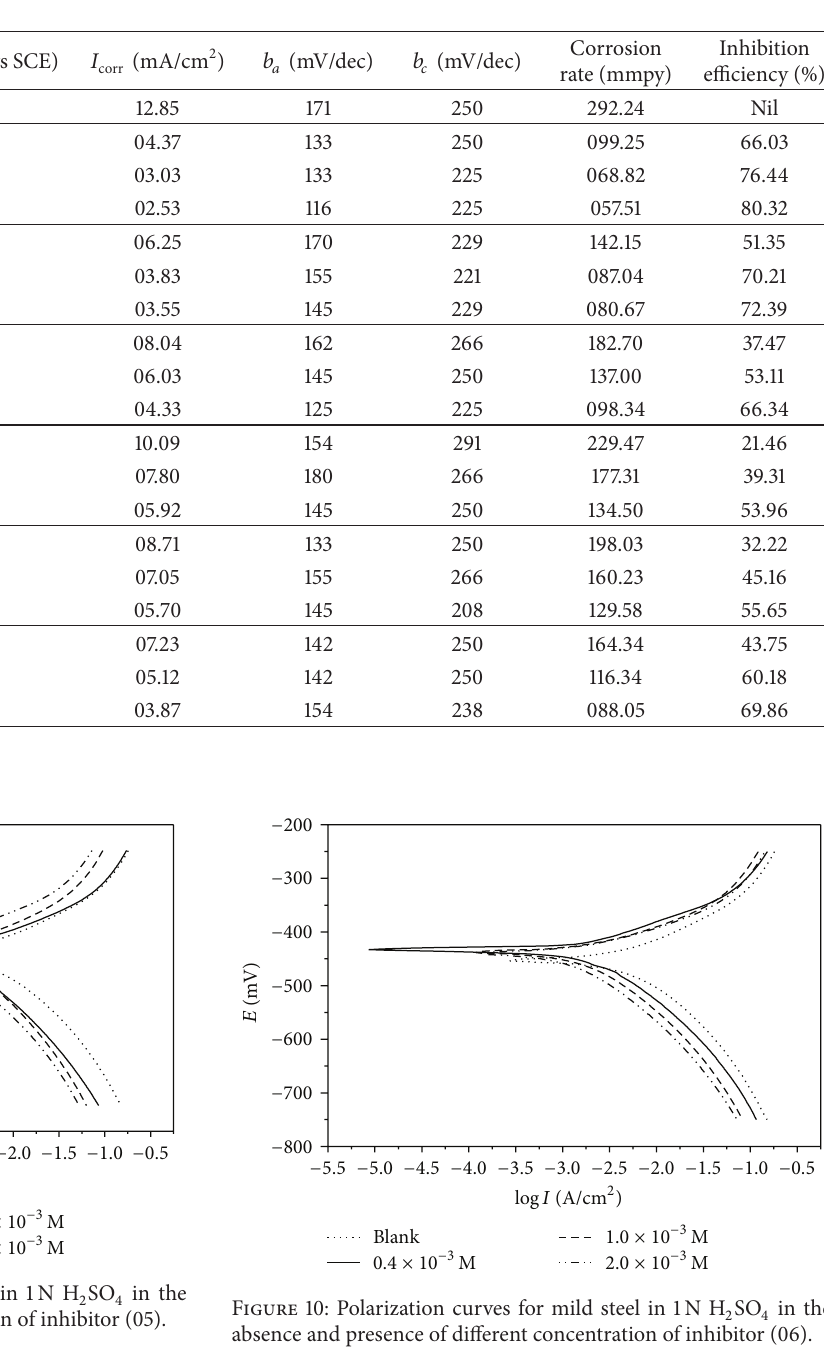
Table 5: Polarization parameters for mild steel in 1N H piperidin-4-ones.